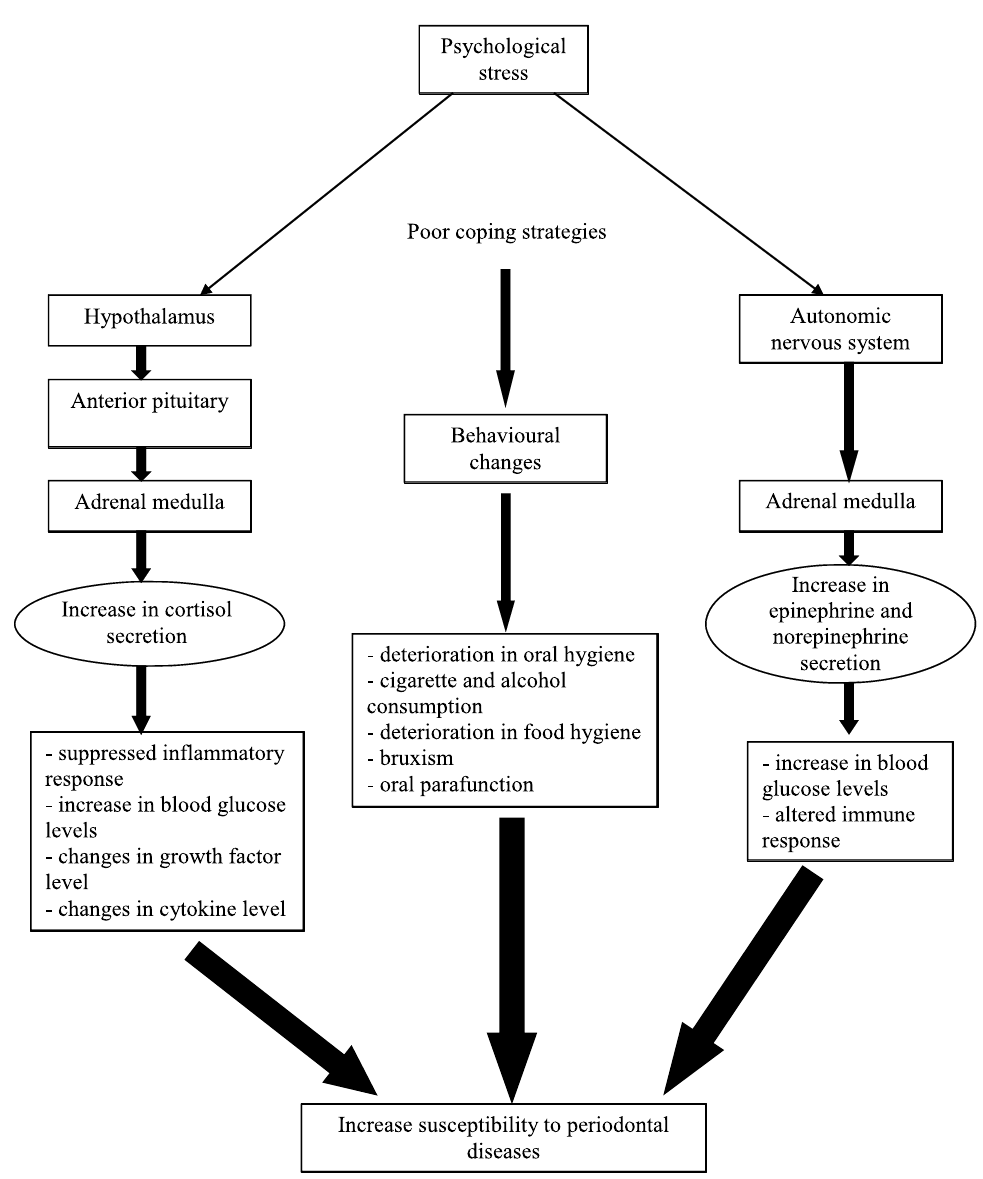
Fig. 1. Biological mechanisms and behaviors linking stress and periodontal disease